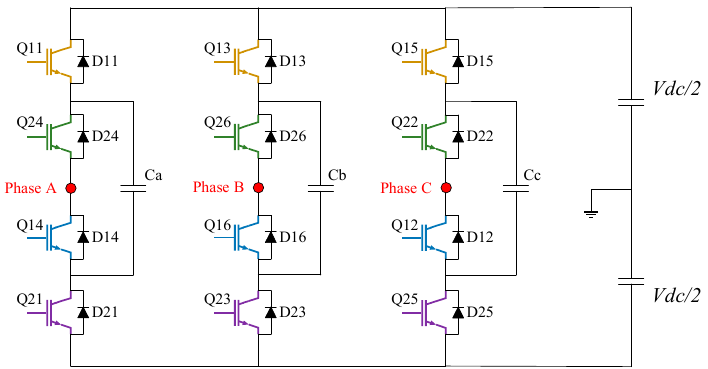
Figure 7. Three-phase three-level FCC VSC converter.